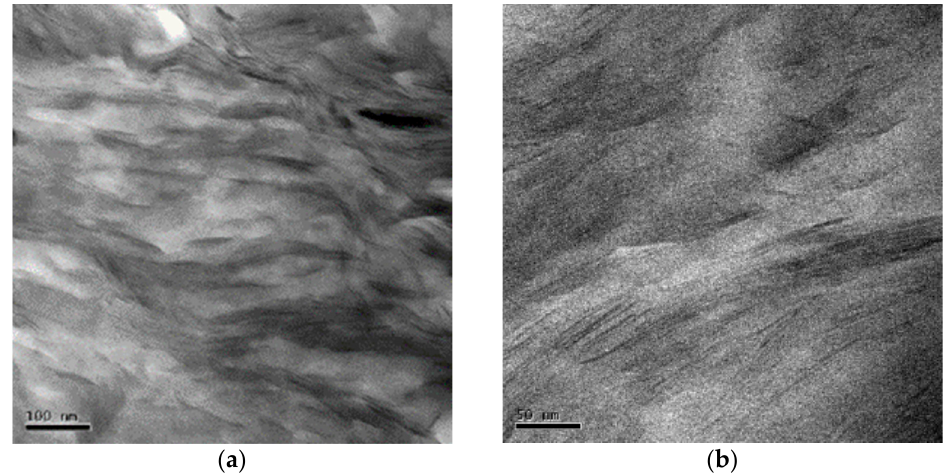
Figure 9. Transmission electron micrographs of the PoB5H25 composite: ( a ) increase of 200,000×, ( b ) increase of 400,000×.